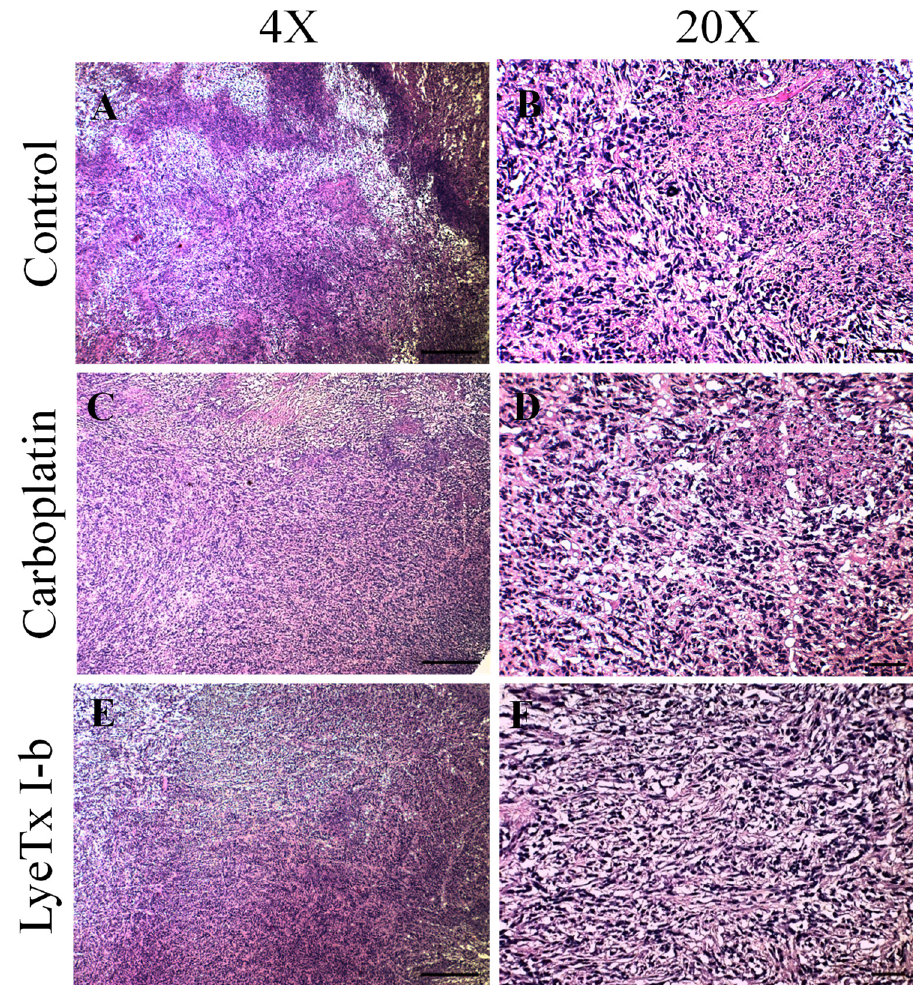
Figure 8. Histological effects of subcutaneous administration of LyeTx I-b on4T1 murine primary tumor, n = 6. ( A , B ) The control group exhibited the presence of neoplastic cells with a high degree of cellular polymorphism. ( C , D ) The carboplatin group showed inflammatory infiltrate characterized by mononuclear and neoplastic cells with a high degree of polymorphisms. ( E , F ) The reduction of areas of necrosis and fibrosis in the tumor periphery. ( B , F ) The group treated with LyeTx I-b presented a reduction in neoplastic cells and necrotic areas, associated with increased deposition of fibrous connective tissue. H&E staining. Objectives: 4× and 20×. Scale bars: 200 µm and 40 µm.